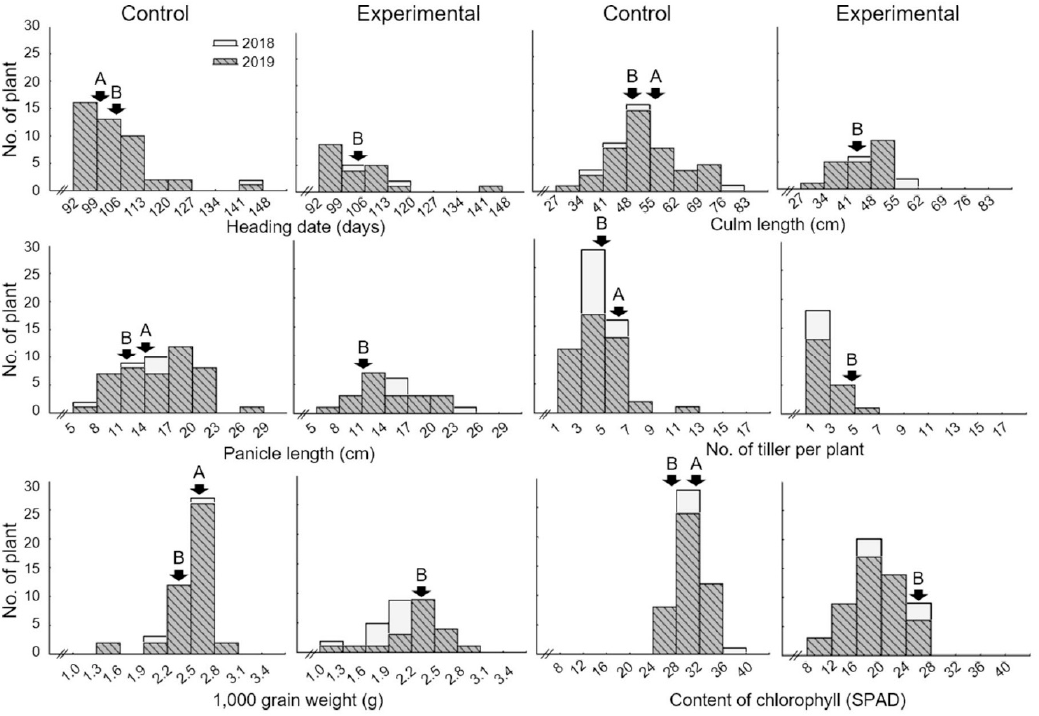
Figure 2. The frequency distribution of heading date, culm length, panicle length, number of tillers, 1000 grain weight, and content of chlorophyll in the CNDH population. As all traits showed a normal distribution, the investigated traits were considered to be quantitative traits. Cheongcheong is a high-temperature resistant variety, and Nagdong is a high-temperature sensitive variety. A, Cheongcheong; B, Nagdong.